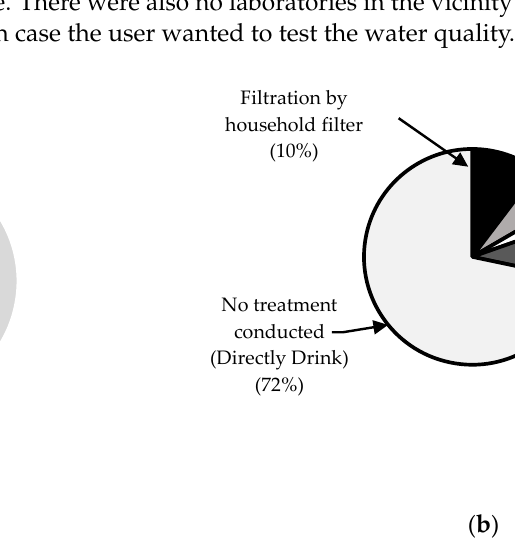
Figure 8. ( a ) Type of tests carried out by household RWH users; ( b ) treatment methods for harvested rainwater location of the tank. The values in the parenthesis indicate the proportion of households.